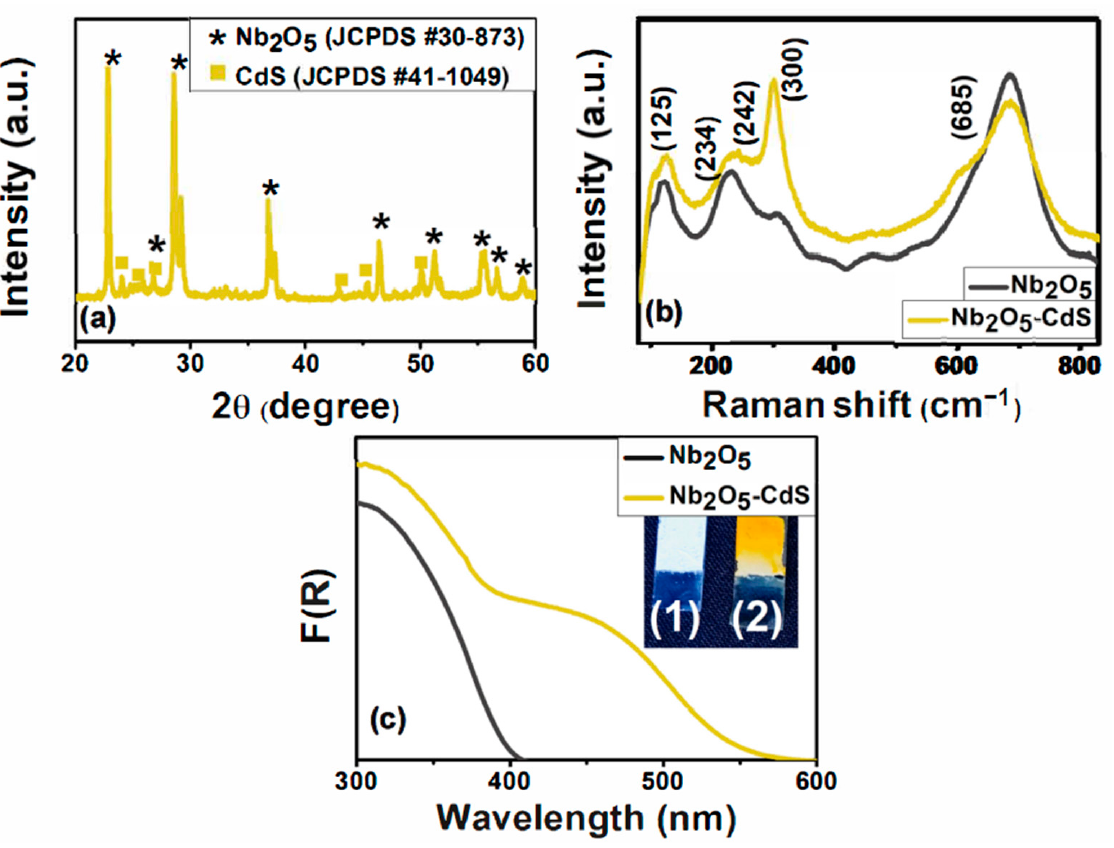
Figure 4. X-ray diffraction pattern for Nb 2 O 5 -CdS composite ( a ). Raman spectra for Nb 2 O 5 and Nb 2 O 5 -CdS samples ( b ). DRS spectra for Nb 2 O 5 inserted image (1) and Nb 2 O 5 -CdS inserted image (2) ( c ).